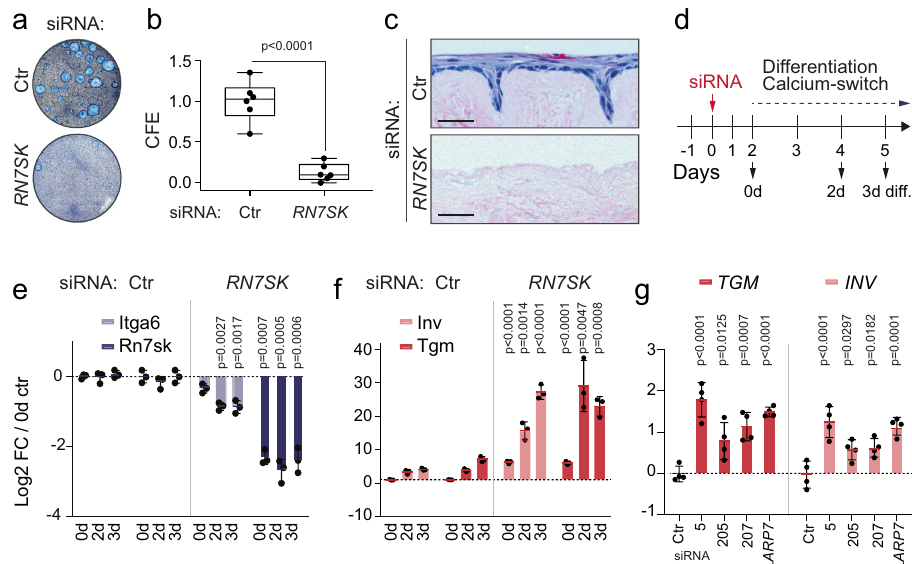
Fig. 2 RN7SK-depletion induces differentiation of primary human keratinocytes. a , b Representative image ( a ) and quanti fi cation ( b ) of the colony- forming assay (CFE) using primary human keratinocytes transfected with control (Ctr) or RN7SK siRNAs ( n = 6 transfections). Box plots show all data points, median, interquartile range, and whiskers ending at minimum and maximum values. c H&E staining of human skin reconstituted ex vivo on de- epidermalised dermis (DED) using primary human keratinocytes transfected with Ctr or RN7SK siRNAs. Shown is one representative image out of two DED assays. Scale bars: 10 μ m. d – g Treatment regime in days ( d ) and log 2 fold-change (FC) of RNA levels of Integrin α 6 ( ITGA6 ; light blue) and RN7SK (dark blue) ( e ), or Transglutaminase 1 ( TGM ; red) and Involucrin ( INV ; pink) ( f ) in transfected human keratinocytes. ( n = 3 transfections). g Log2 FC of Tgm and Inv RNA levels in human keratinocytes 48 h after transfection of the indicated siRNAs ( n = 4 transfections). 5, 205, and 207: different siRNAs targeting RN7SK . Data are normalized to GAPDH ( e – g ). Shown is mean ± SD ( e − g ). Two-tailed unpaired t-test ( b ). One-way ANOVA ( e − g ). Exact p -values are indicated. Source data are provided as a Source Data fi